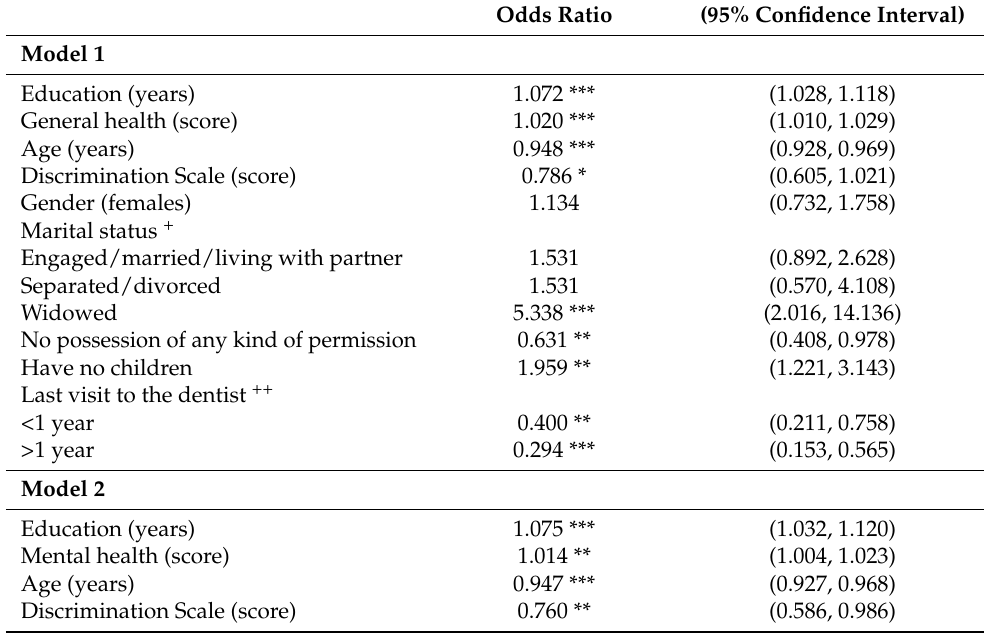
Table 5. Logistic regression models that investigated the impact of quality of life, sense of discrimination, presence of any kind of permission and demographics on dental health status (dependent